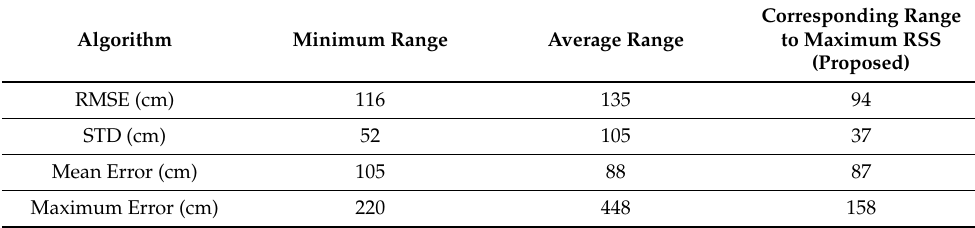
Table 4. Estimated position errors with respect to range utilization method.